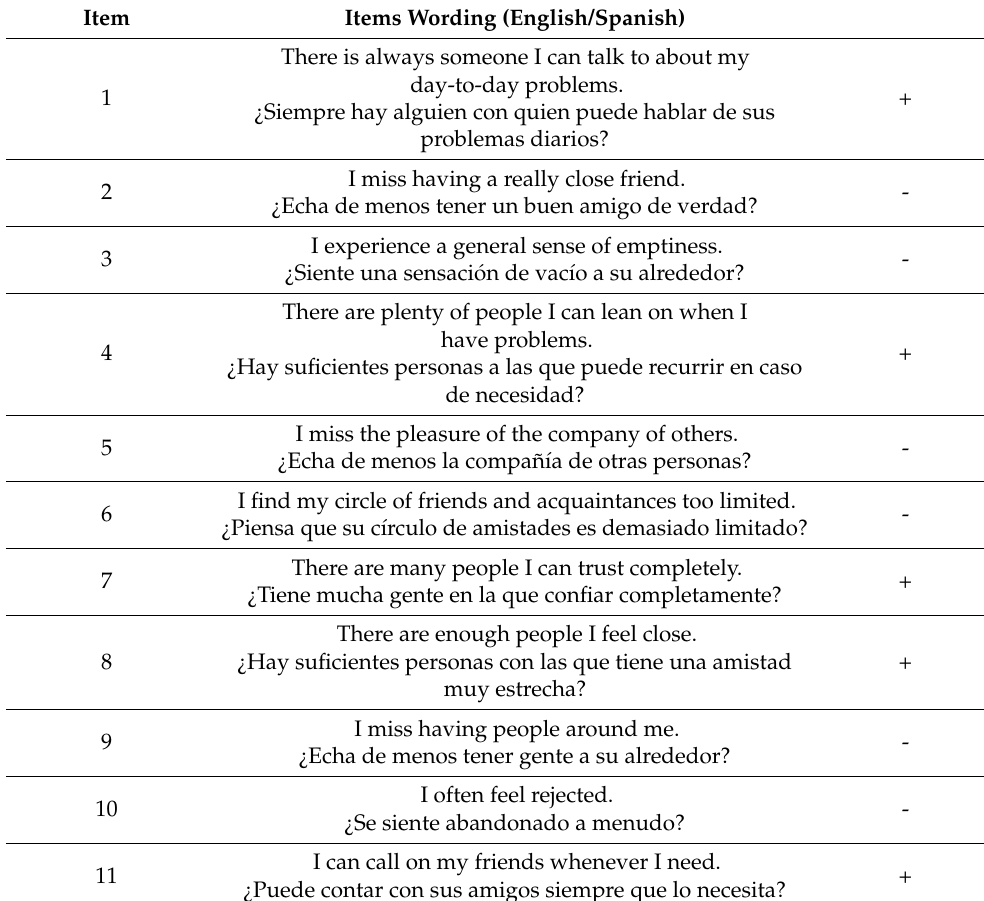
Table 1. The 11 items of the